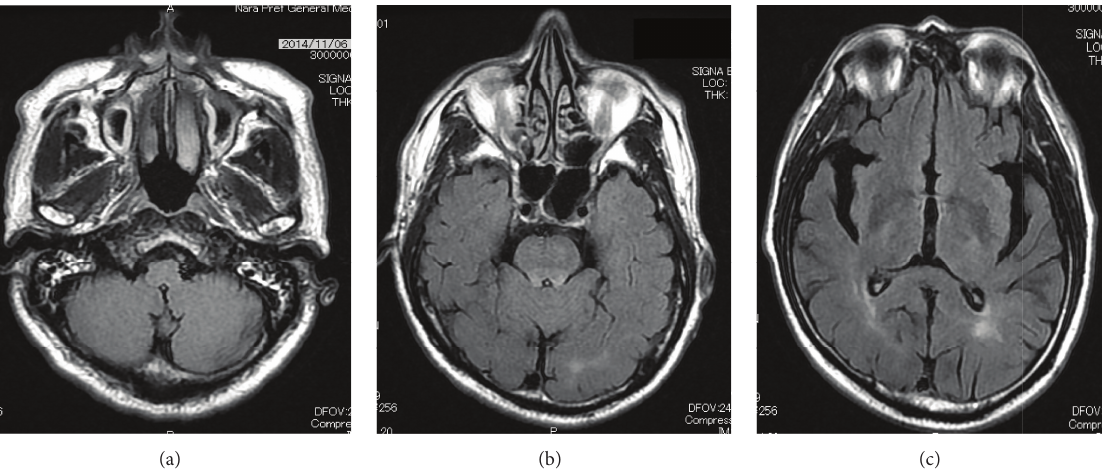
Figure 2: MRI (FLAIR images) of the brain after treatment. The multiple high-intensity lesions significantly improved. ((a) Cerebellar lobes lesions, (b) occipital lobes and dorsal brain stem lesions, and (c) left thalamus and occipital lobes lesions.)